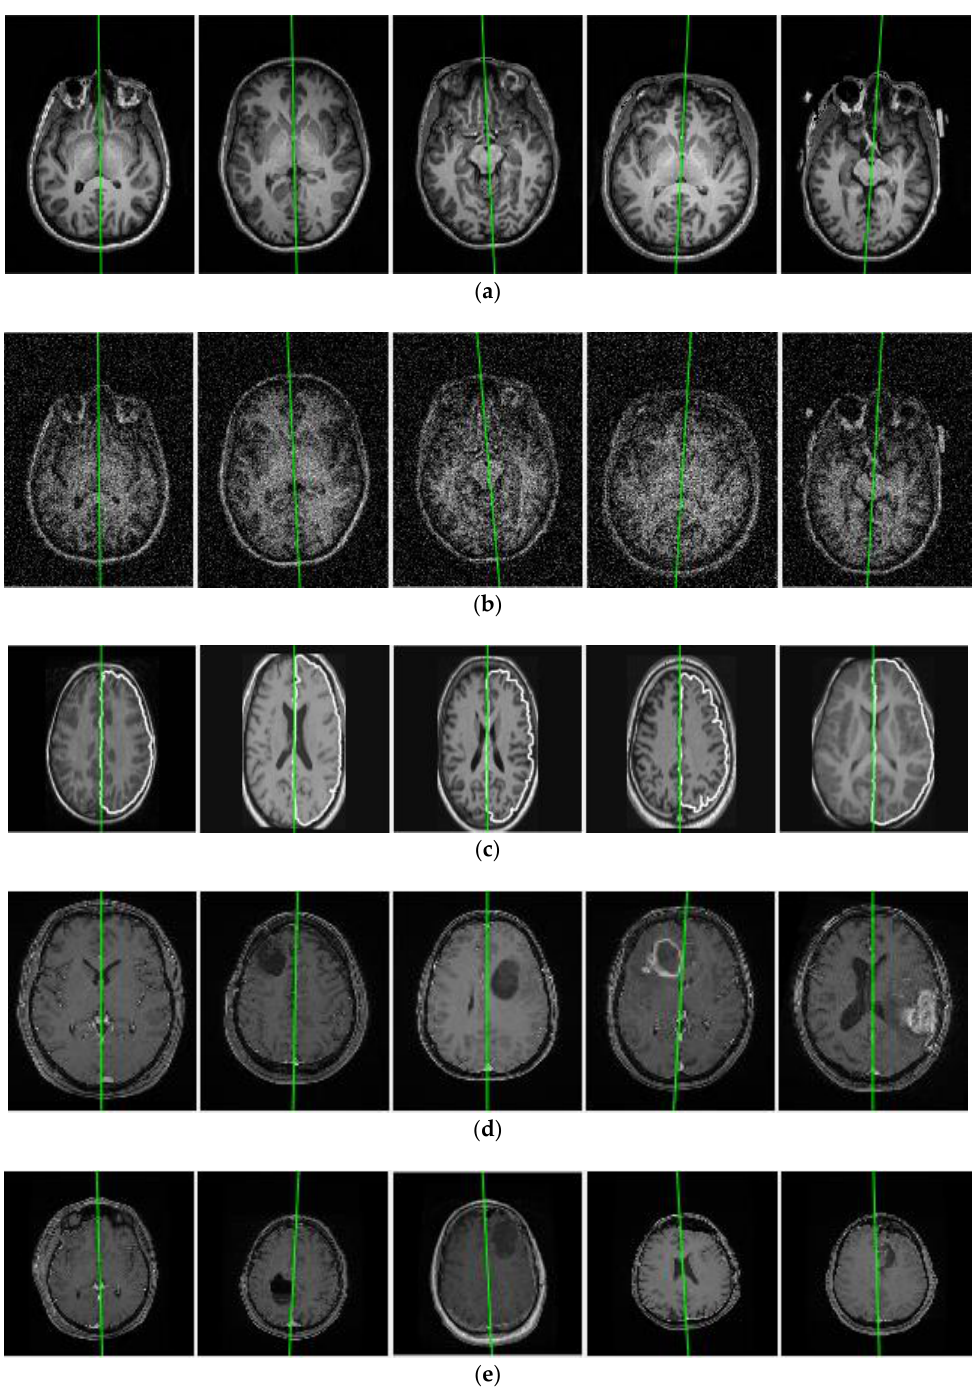
Figure 9. Visual comparison of the proposed algorithm in extracting the symmetric axis (MSP) from real brain MRIs, ( a ) the NFBS database [38], ( b ) images of the same subjects with Gaussian noise, ( c ) the IBSR database [39], ( d ) the MNI BITE database Group 2, and ( e ) the MNI BITE database Group 3